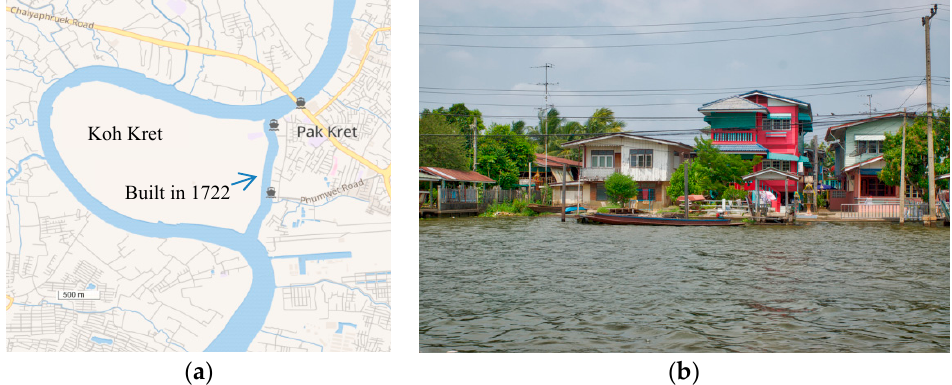
Figure 10. River landform at Koh Kret and a typical riparian landscape along the bend and shortcut. ( a ) River landform; ( b ) Typical riparian landscape.